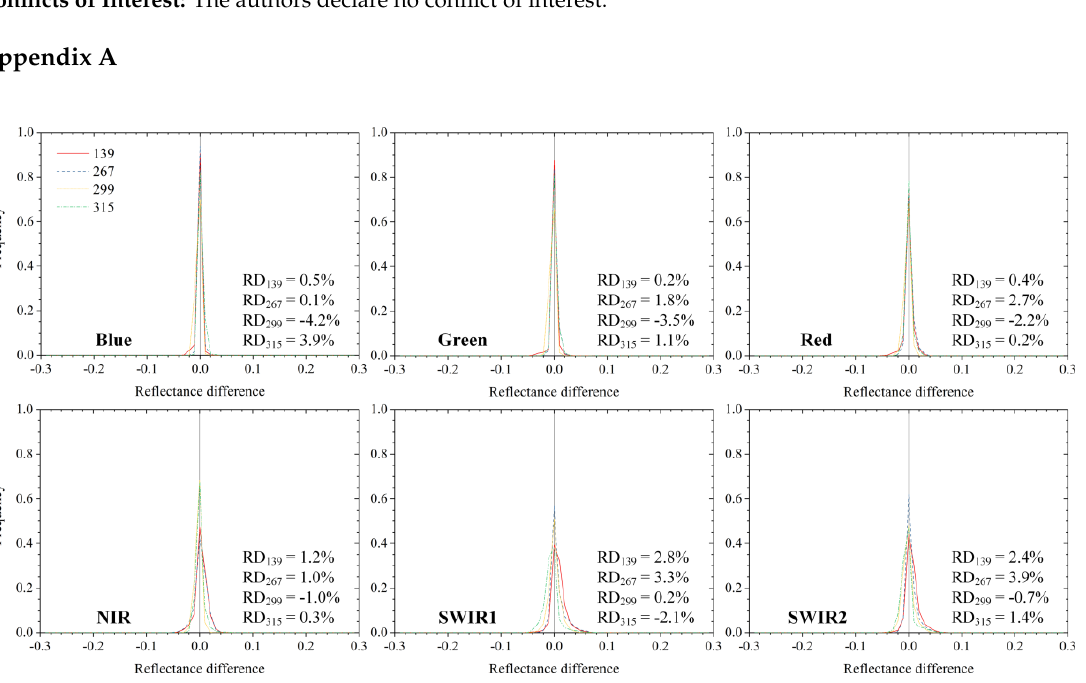
Figure A1. Histograms of residuals between the CACAO reconstructed reflectances and the Landsat 8 OLI observed reflectances on DOY 139 (red solid lines), 235 (blue dashed lines), 299 (orange dotted lines), and 315 (green dash-dotted lines) for the different spectral bands. The statistics refer to the relative differences (RD).